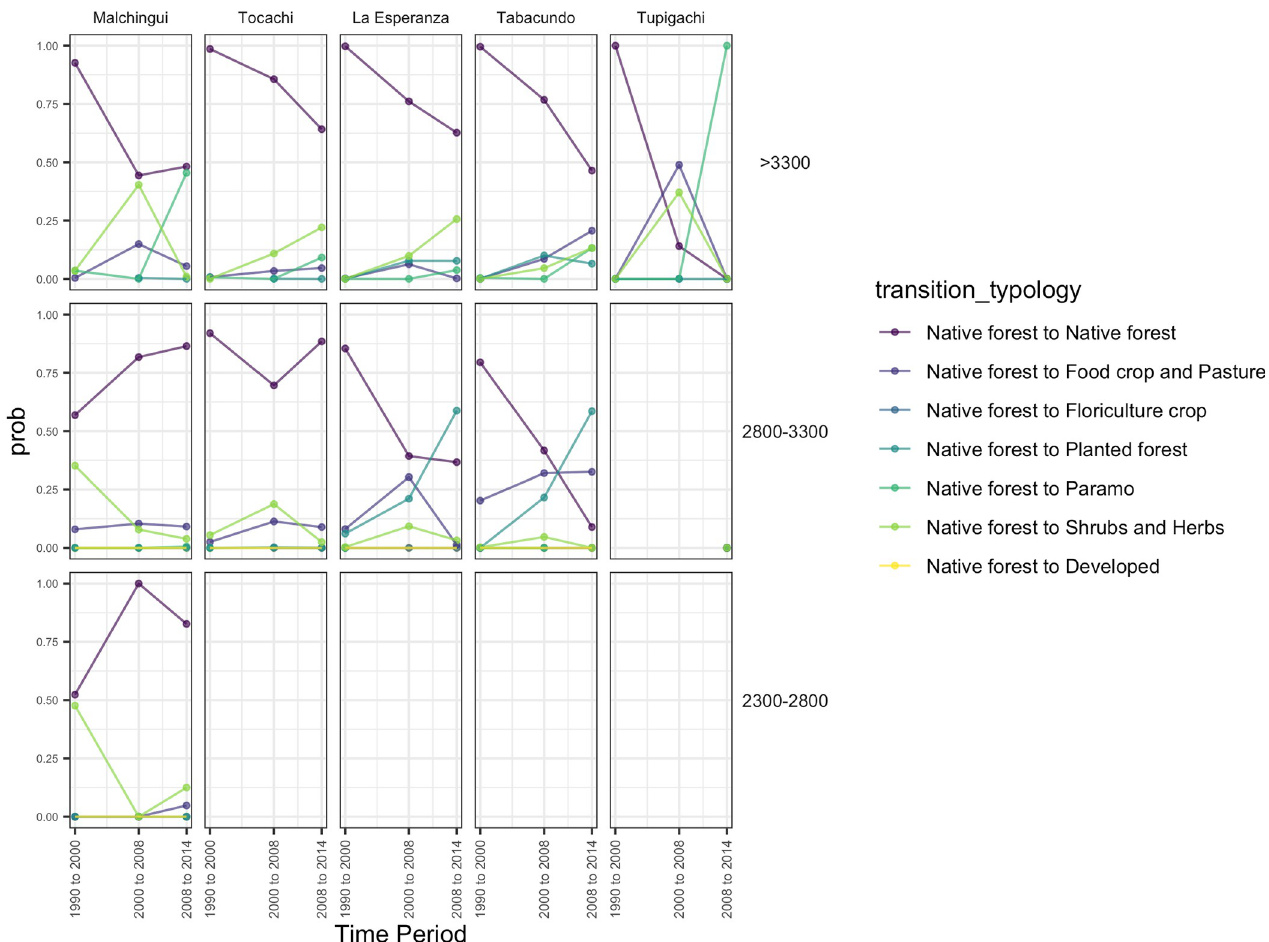
Fig 5. Transition probability of native forests through time in Pedro Moncayo county, by altitudinal bands at the parish level.